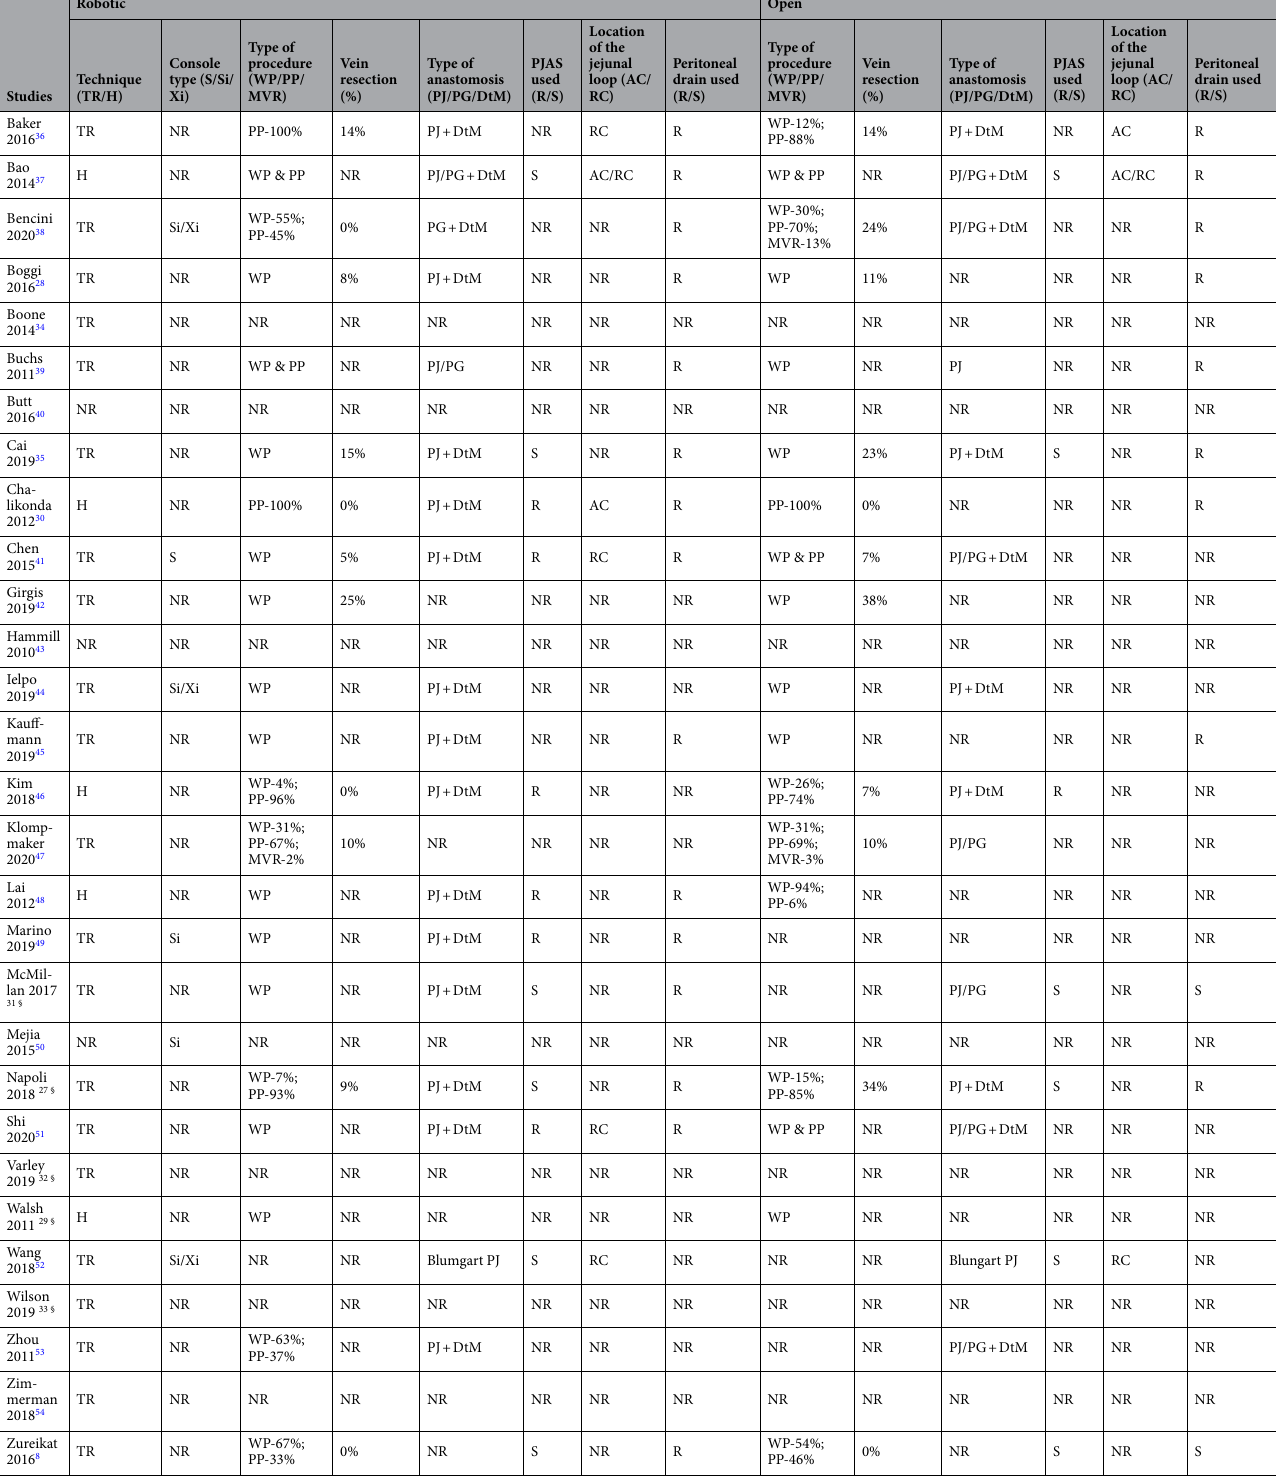
Table 3. Definition of interventions in included studies. TR totally robotic; H hybrid; WP Whipple procedure; PP pylorus preserving; MVR multivisceral resection; PJ pancreaticojejunostomy; PG